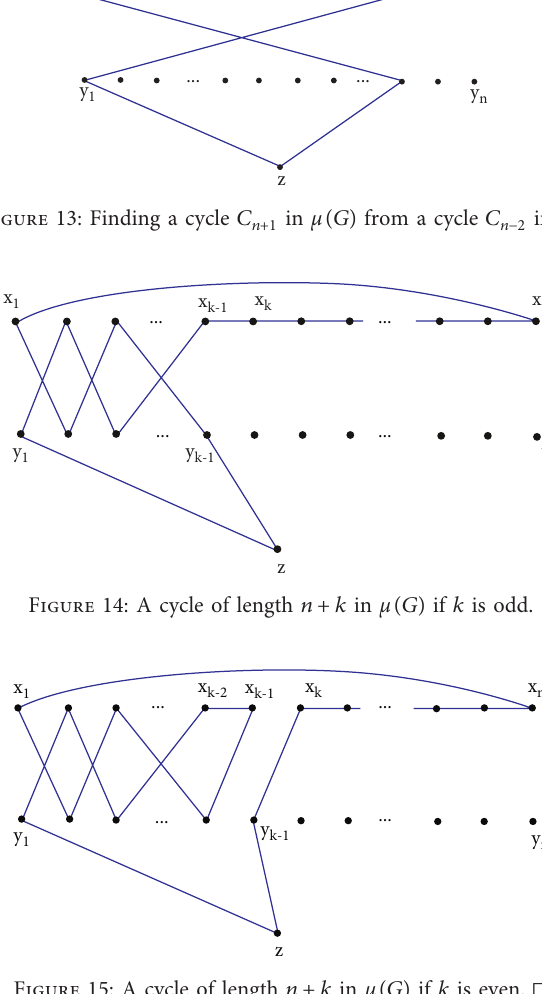
Figure 15: A cycle of length n + k in μ ( G ) if k is even.